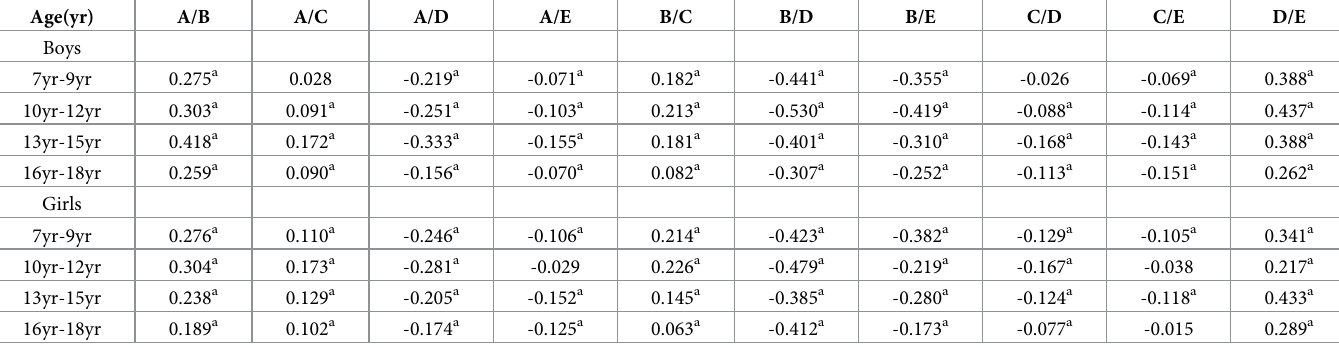
Table 2. Correlations between health test indicators for participating children and adolescents by age group ( r